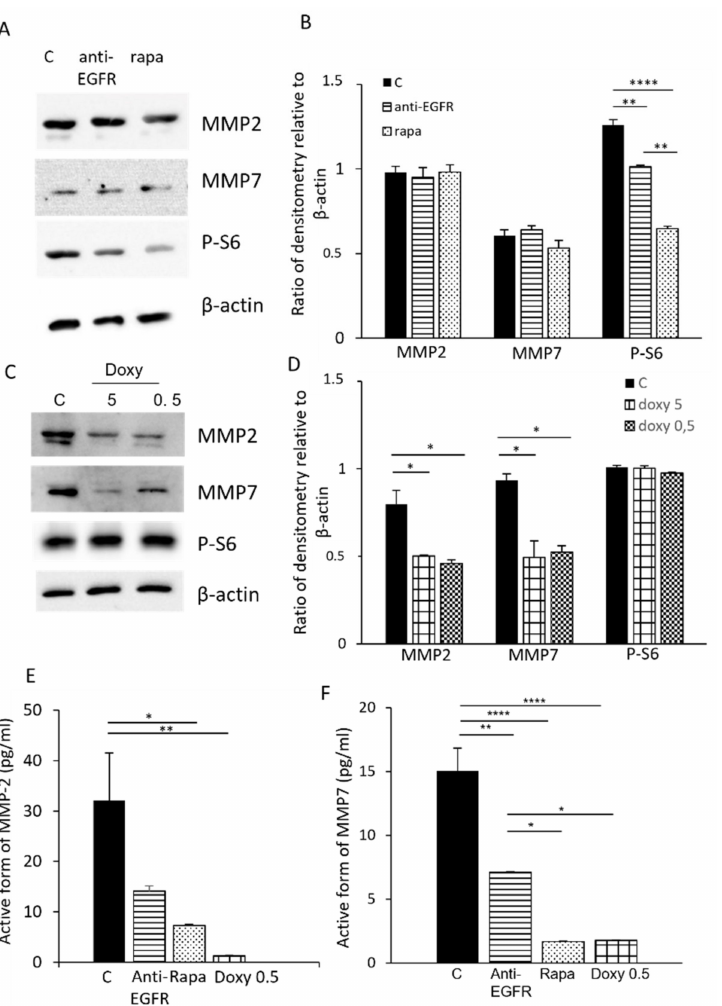
Figure 2. Effect of anti-EGFR antibody and rapamycin on MMP-2 and MMP-7 expression and activity. ( A ) MMP-2 and MMP-7 expression and S6 phosphorylation were analyzed by Western blot after incubation with anti-EGFR antibody (5 µ g/mL) or rapamycin (5 ng/mL) for 48 h. Representative images are shown. ( B ) Relative intensity by densitometric analysis was evaluated relative to β -actin levels. ( C ) MMP-2 and MMP-7 expression, and S6 phosphorylation were evaluated by Western blot following incubation with doxycycline (5 and 0.5 µ M) incubated for 48 h. β -actin was used as an internal reference of total protein. ( D ) Relative intensity by densitometric analysis was evaluated relative to β -actin levels. ( E ) MMP-2 activity and ( F ) MMP-7 were analyzed by using a QuickZyme assay in control cells ( C ) and in cells incubated with anti-EGFR antibody, rapamycin, or doxycycline. ANOVA with Tukey test ± SEM ( n = 3 experiments) * p < 0.05 ** p < 0.01; **** p <